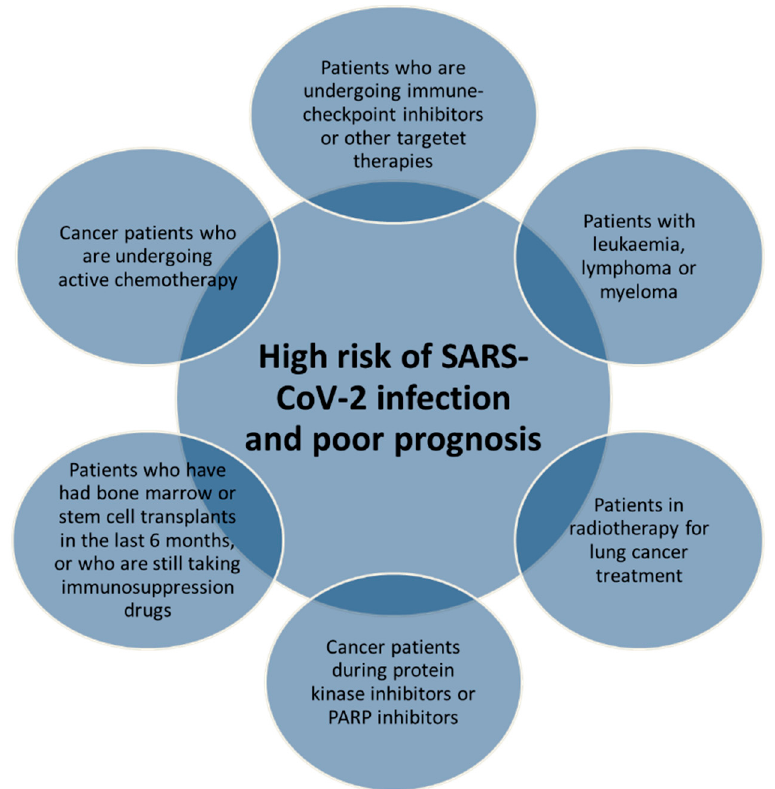
Figure 3. Overall risk factors for cancer patients according to “Clinical guide for the management of noncoronavirus patients of National Health Service England”